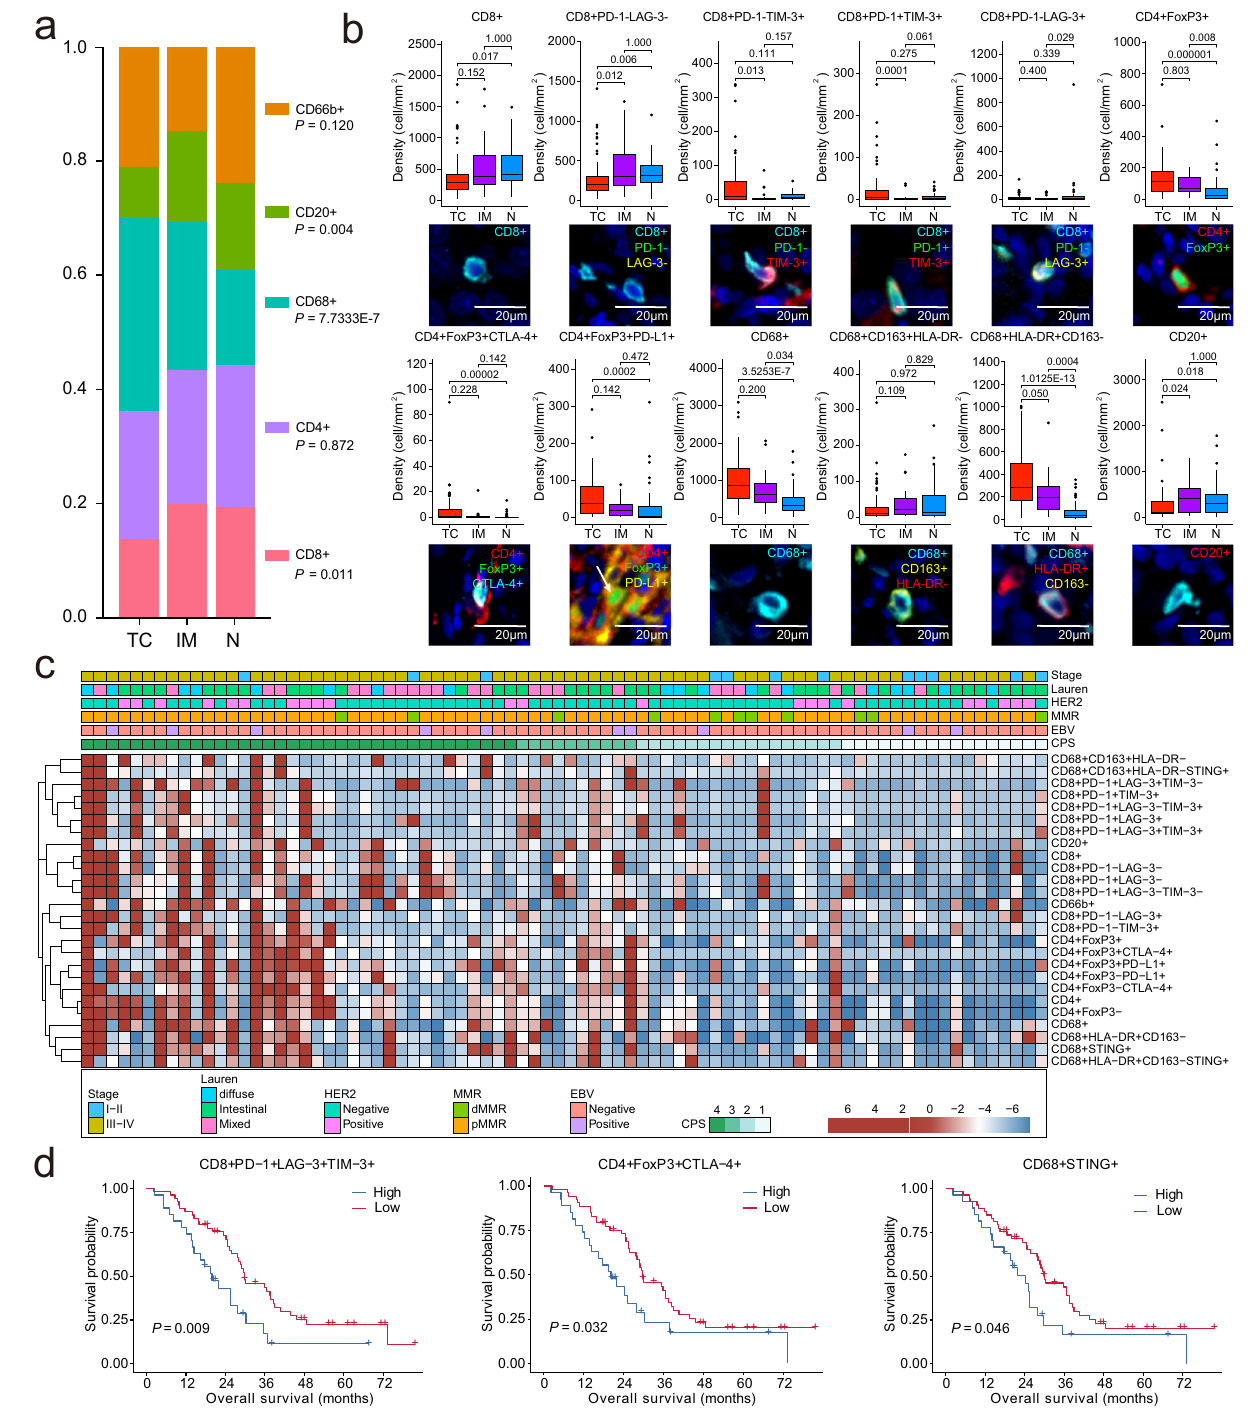
Fig.2|Automatedimageanalysishighlightstheorderedimmunecomposition ingastriccancer.a Constitutionofthemaintumour-in fi ltratingimmunecell(TIIC) populations. Kruskal – Wallis test with the Dunn ’ s multiple comparison test. b Density of TIICs across the regions of interest ( n =80). TC, tumour core; IM, invasion margin; N, normal tissue. Immuno fl uorescence staining images refer to the co-expression of the corresponding markers and DAPI (nuclei). Scale bar: